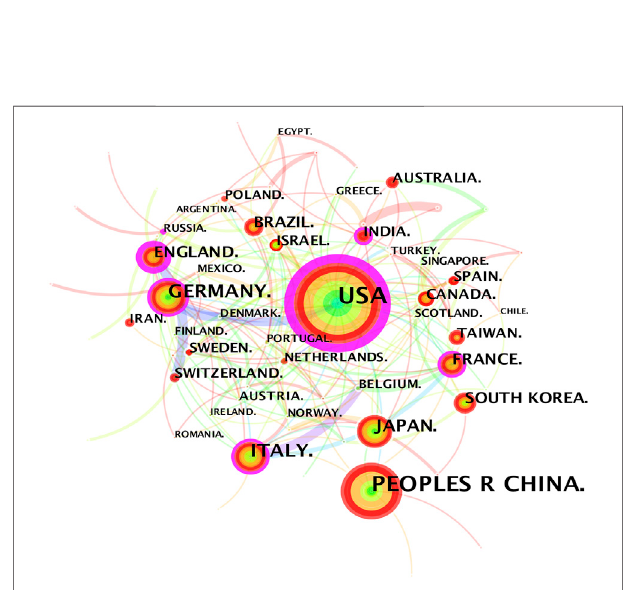
FIGURE 2 | Country/region co-occurrence knowledge map of the in fl ammatory tumor microenvironment.